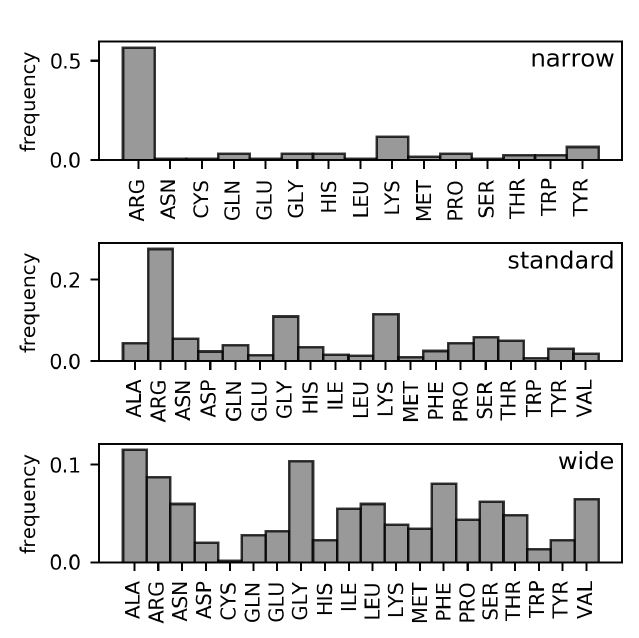
Figure 2. Frequencies of amino acids contacting narrow, standard, and wide DNA minor grooves (DS1 dataset).